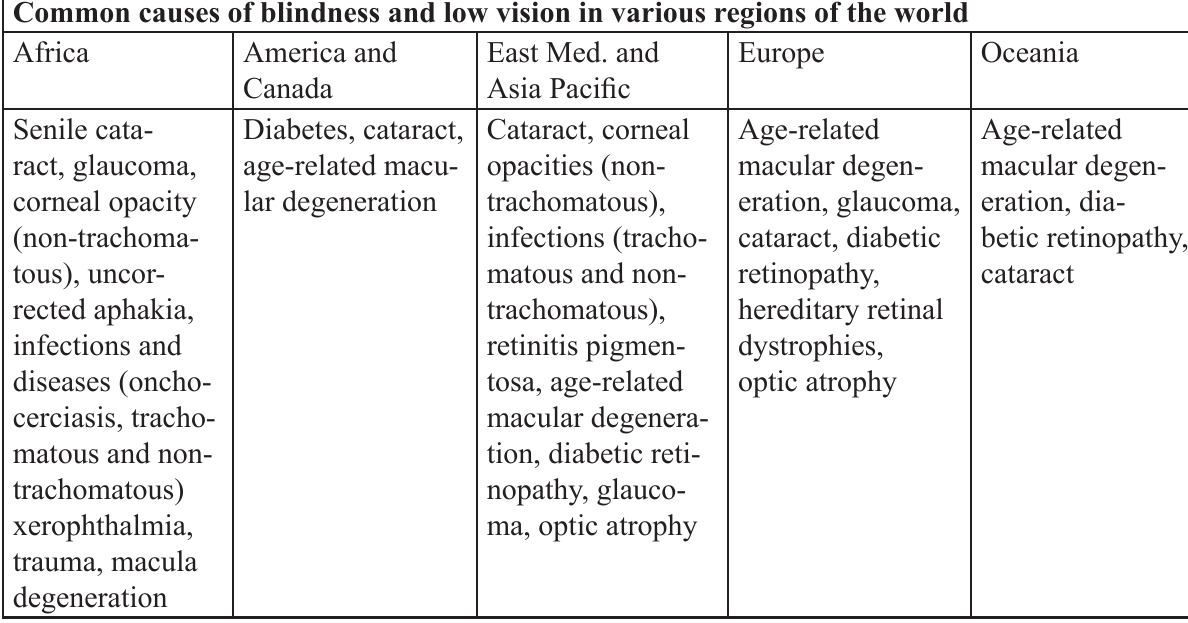
Table 1. Causes of low vision and blindness in different parts of the world. Common causes of blindness and low vision in various regions of the